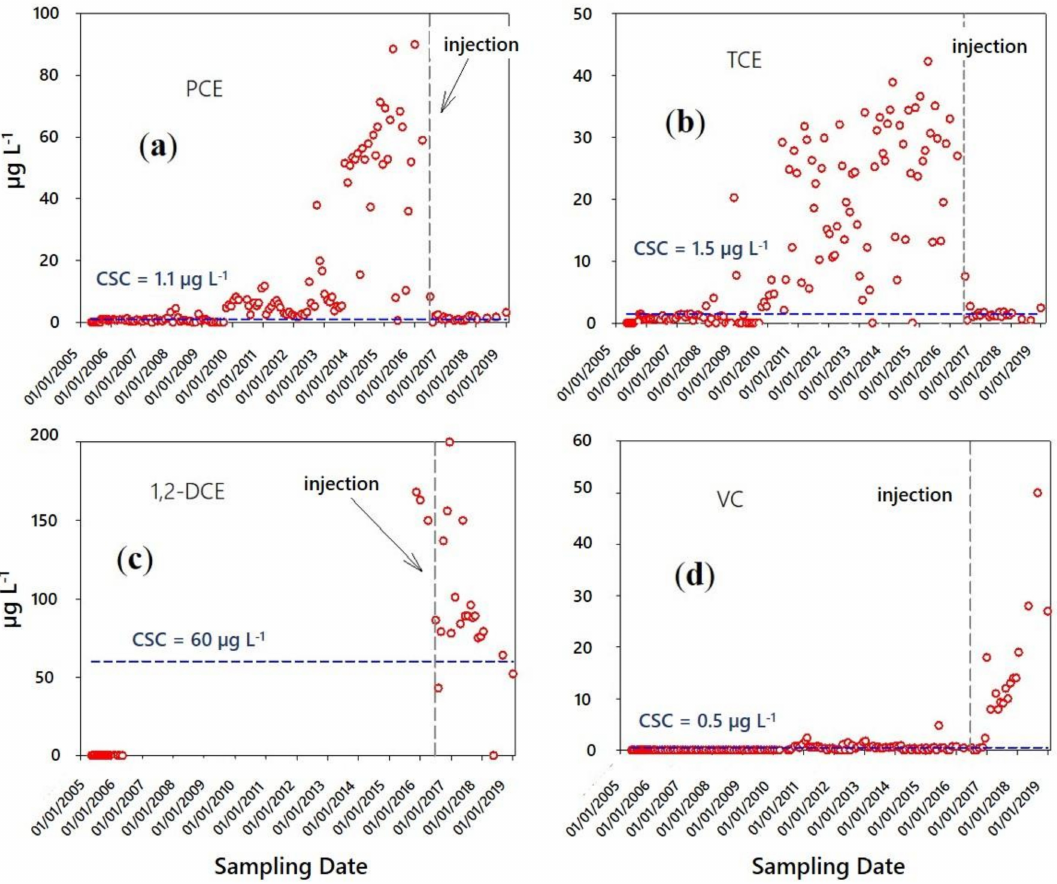
Figure 12. ( a ) PCE, ( b ) TCE, ( c ) 1,2-DCE, and ( d ) vinyl chloride (VC) concentrations detected in shallow aquifers in the last intervention